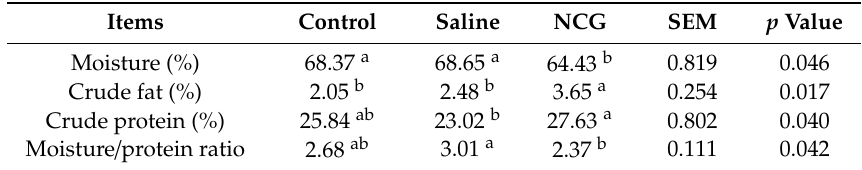
Table 6. Chemistry composition of pectoral muscle in